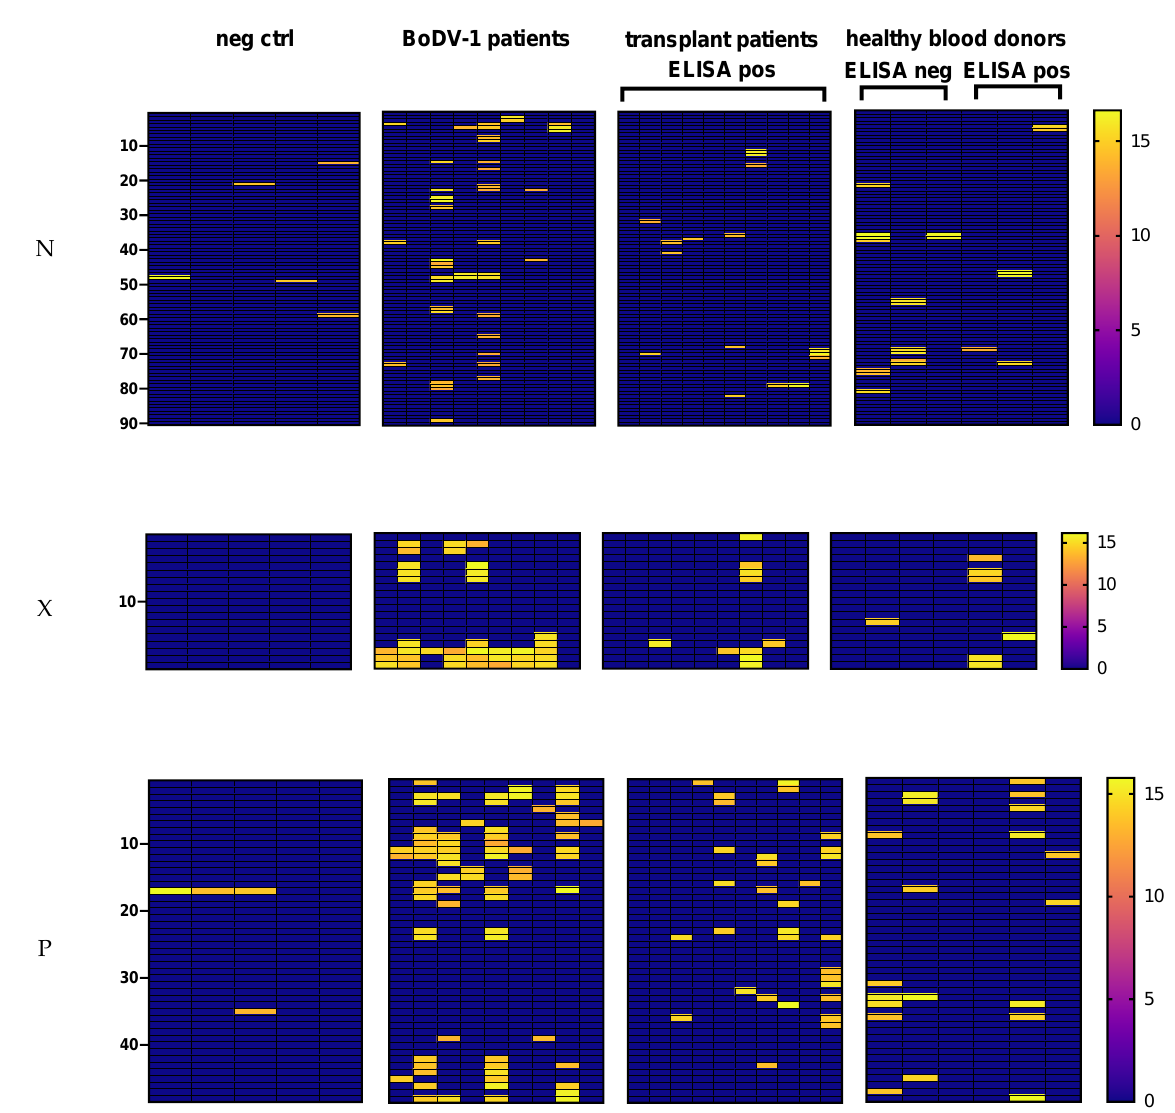
Figure 3. Heatmaps of serological epitope mapping for N (top row), X (middle row), and P proteins (bottom row). The 15-mer peptides are represented in the y-direction from N- (top) to C-terminus (bottom). Individual samples of different cohorts are represented in the x-direction. Values represent the base 2 logarithm-transformed intensity values after background subtraction. An arbitrary cut-off of 13.5 was set to minimize unspecific staining of negative controls samples. Values below the cut-off were set to 0.